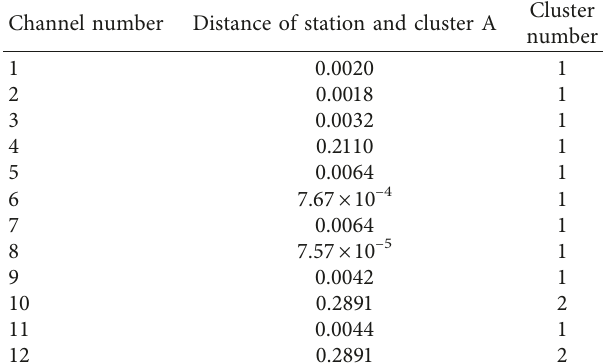
Table 3: Result of first arrival